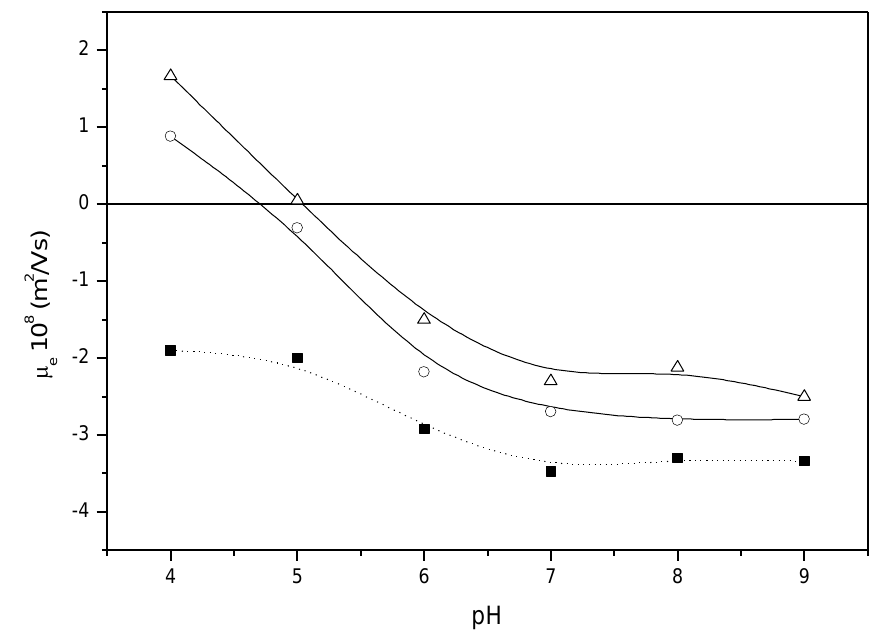
Figure 4. Electrophoretic mobility vs. pH for (■) PhS; (○) PhS-1 mgIgG/m 2 ; and (∆) PhS-2.5 mgIgG/m 2